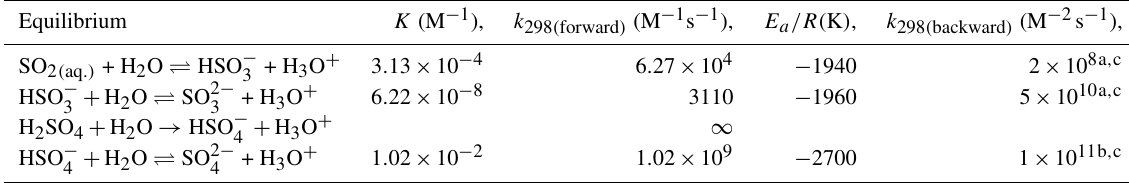
Table 2. Sulfur aqueous equilibria. Equilibrium